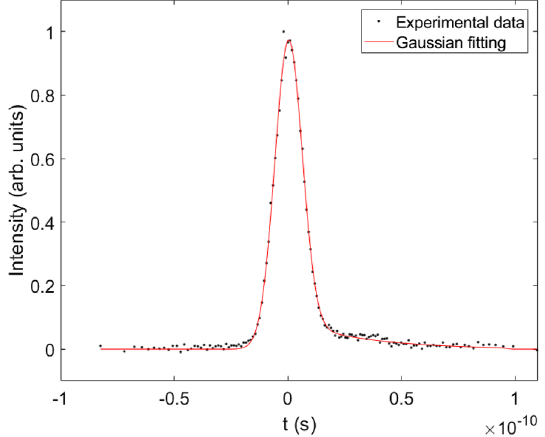
ps.FIG. 6. Time response measurement of the bulk GaAs cathode at laser wave length of 520 nm (dots) by the projection of the bunch traces taken by the beam profile monitors. The solid line shows the fitting curve obtained by the least squares method using the model cathode response